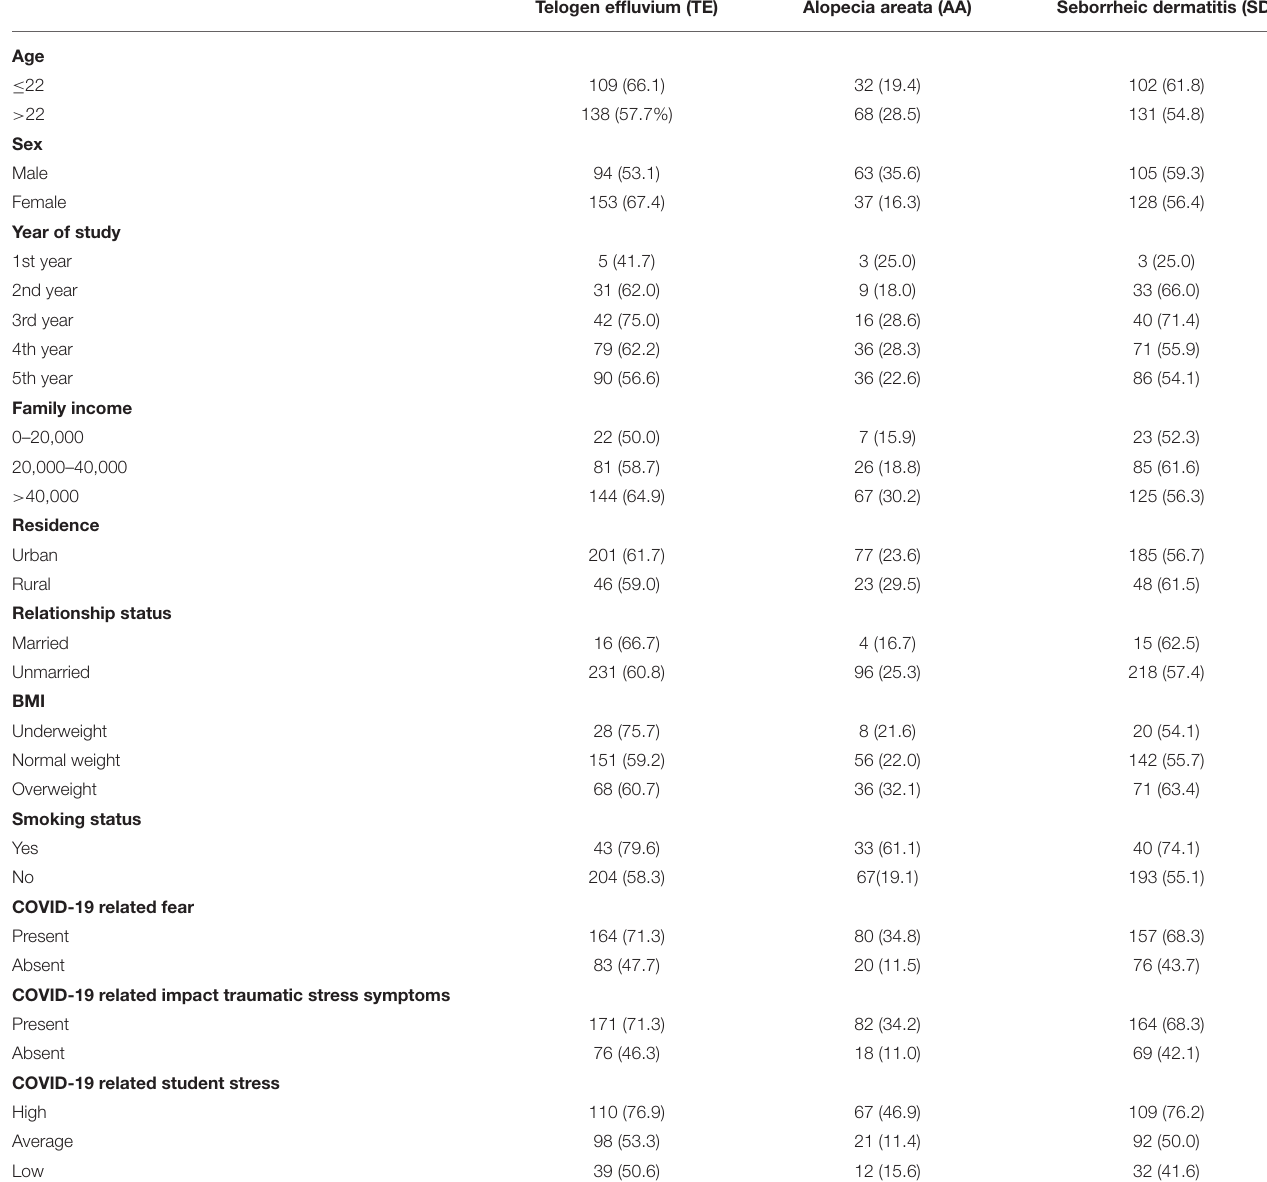
TABLE 2 | Prevalence of TE, AA, and SD according to participants’ characteristics ( n = 404). Telogen effluvium (TE) Alopecia areata (AA) Seborrheic dermatitis